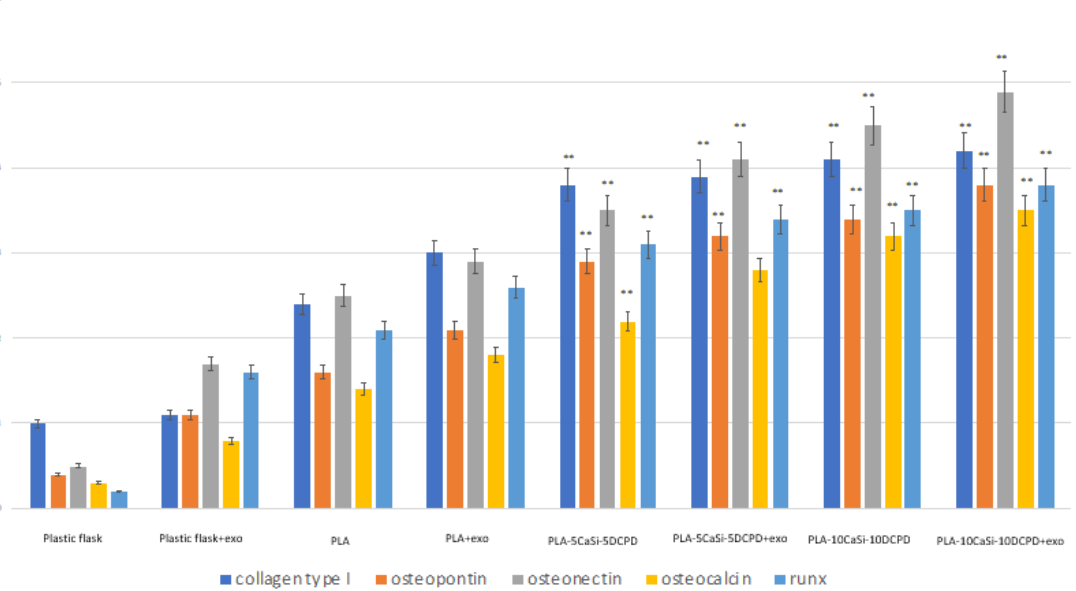
Figure 10. Gene expression of hAD-MSCs cultured on monolayer in plastic flasks, in plastic flasks with exosomes, in plastic flasks in presence of PLA (control), in presence of PLA-5CaSi-5DCPD or PLA-10CaSi-10DCPD sca ff olds, and in presence of PLA-5CaSi-5DCPD sca ff olds enriched with exosomes or PLA-10CaSi-10DCPD sca ff olds enriched with exosomes. T -tests were used to determine significant di ff erences ( p < 0.05). * p < 0.05; ** p < 0.01; *** p < 0.001 in comparison with PLA control. No